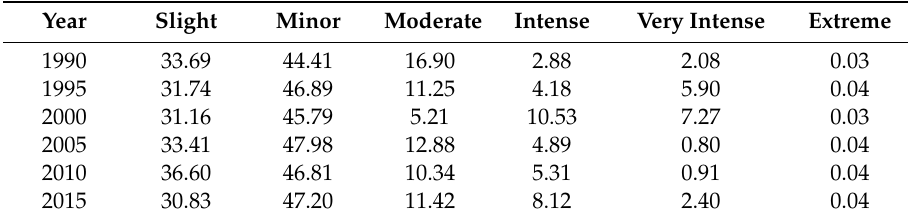
Table 2. Percentage of soil erosion area at all levels in the TGRA from 1990 to 2015 (%).